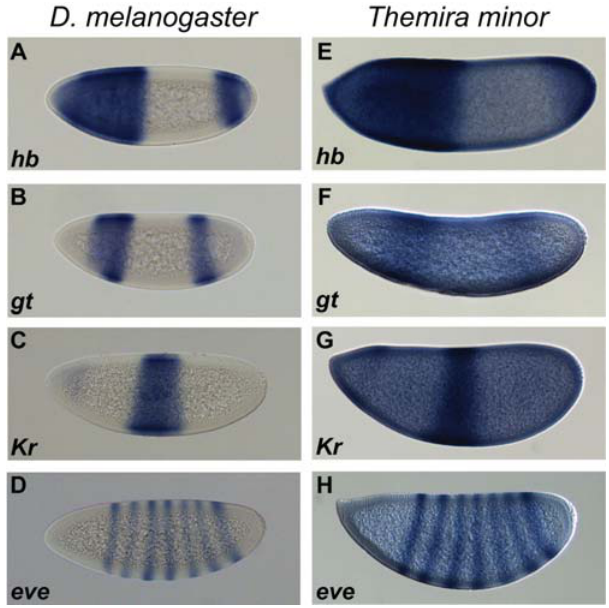
Figure 4. Expression of eve and its upstream transcriptional regulators is conserved between Drosophilamelanogaster and the sepsid Themiraminor . Expression patterns were visualized by in situ hybridization with species-specific digoxigenin-labeled antisense RNA probes. The gap transcription factors hb , gt and Kr are expressed in similar domains during stage 5 in D. melanogaster (A–C) and T. minor (E–G). eve is expressed in seven transverse stripes during cellularization in both species (D, H). Embryos are oriented with anterior to the left and dorsal up.